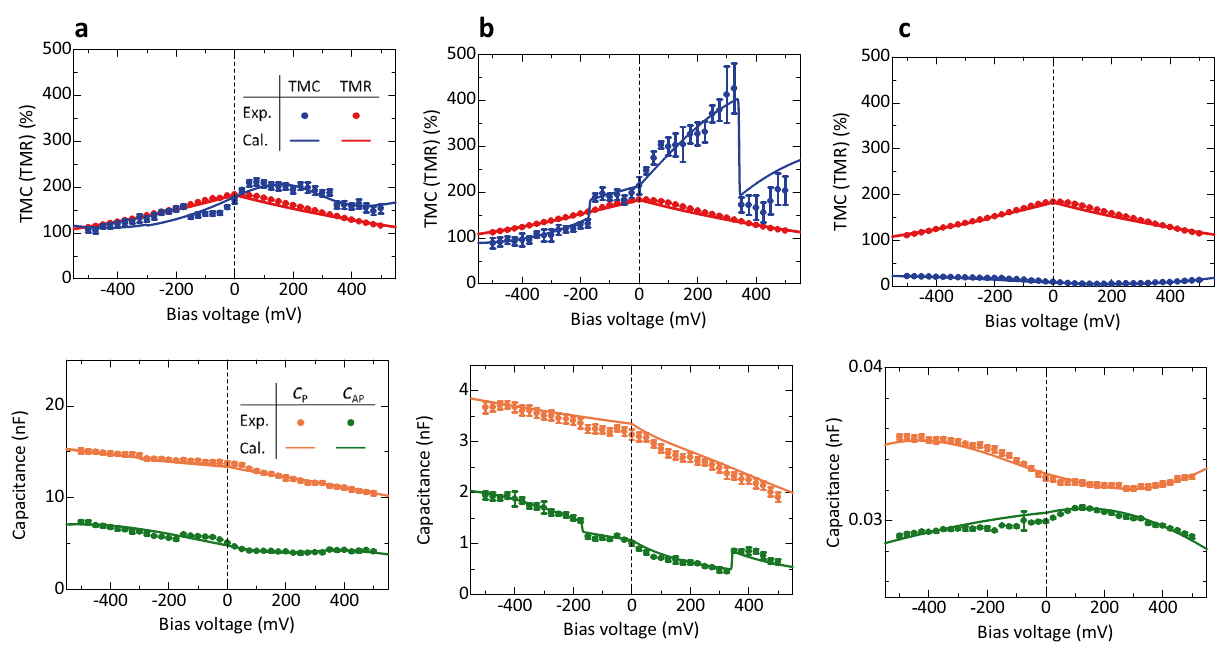
Figure 5. Voltage dependence of TMC, TMR, and C P(AP) for an Fe/MAO/Fe MTJ (sample B). ( a ) At 60 Hz, ( b ) at 140 Hz, and ( c ) at 40 kHz. The solid circles are experimental data and the solid lines are the calculation results. The calculation is performed using SDD model and DF model combined with PBA and Zhang-sigmoid formula (see